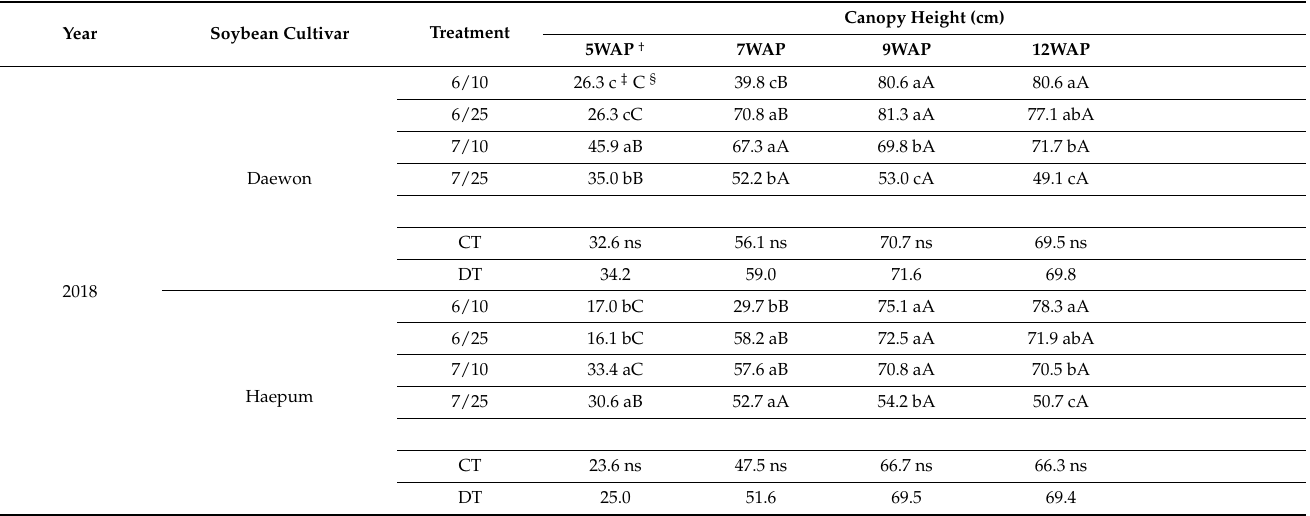
Table 6. Plant canopy height of two soybean cultivars (Daewon and Haepum), as affected by the planting date (6/10, 6/25, 7/10, and 7/25 in 2018; 6/15, 6/30, and 7/15 in 2019–2021) and tillage practice (deep tillage, DT; conventional tillage,